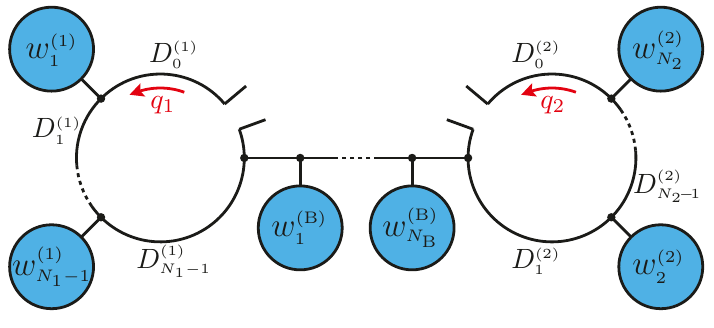
Figure 2 . Cut open reducible two-loop diagram of type